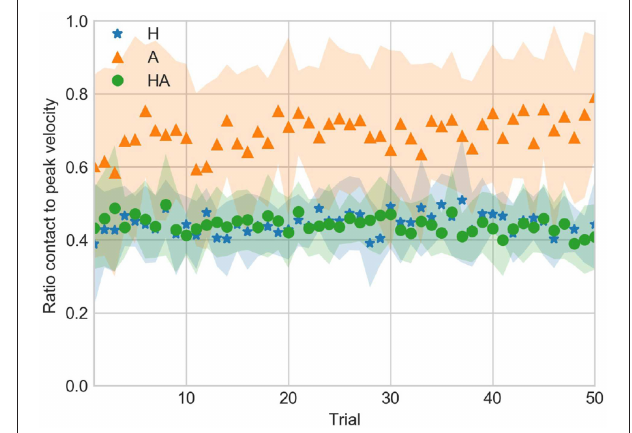
FIGURE 5 | Contact velocity against trial number averaged over all subjects for the haptic (H), acoustic (A), and haptic-acoustic (HA) conditions. The dashed line represents the target contact velocity (0.5 m / s ). The contour represents the standard deviation.